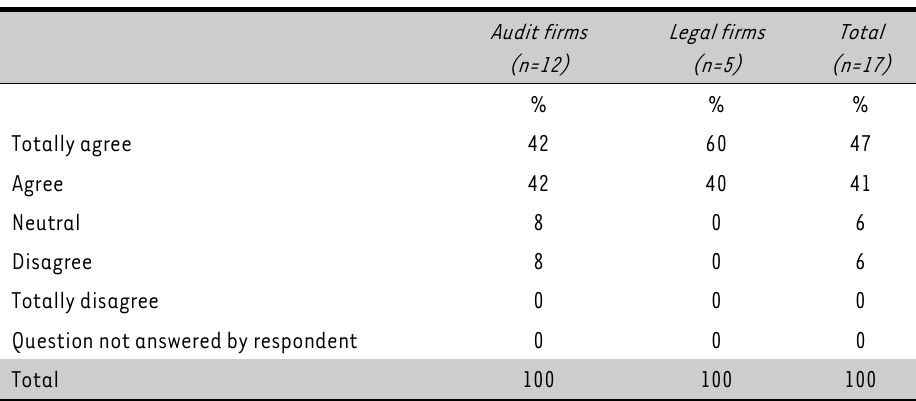
TABLE 10: Results of question